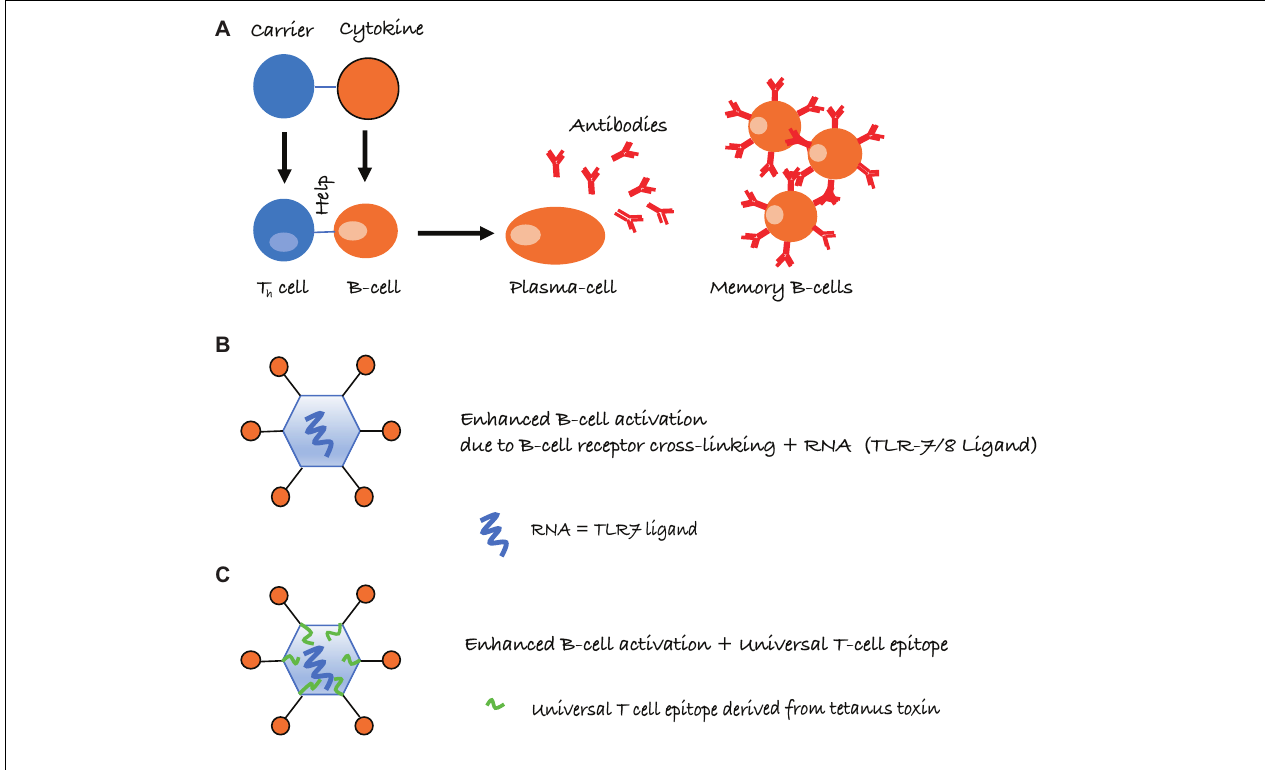
FIGURE 1 | Schematic representation of intermolecular help for the induction of cytokine-specific antibody responses. (A) Cytokines are conjugated to a carrier protein, resulting in cytokine-specific B cells receiving, however, carrier specific T-cell help. (B) Conjugation to virus-like particles (VLPs) further increases antibody responses, due to repetitive display of the antigen and packaged non-coding RNA, which is a ligand for toll-like receptor 7/8 (TLR7/8) and present in many RNA virus-derived VLPs. (C) Presence of a universal T cell epitope may further improve Th cell dependent IgG responses, in particular if the epitope is derived from tetanus toxin (TT), as essentially everybody harbors memory Th cells against